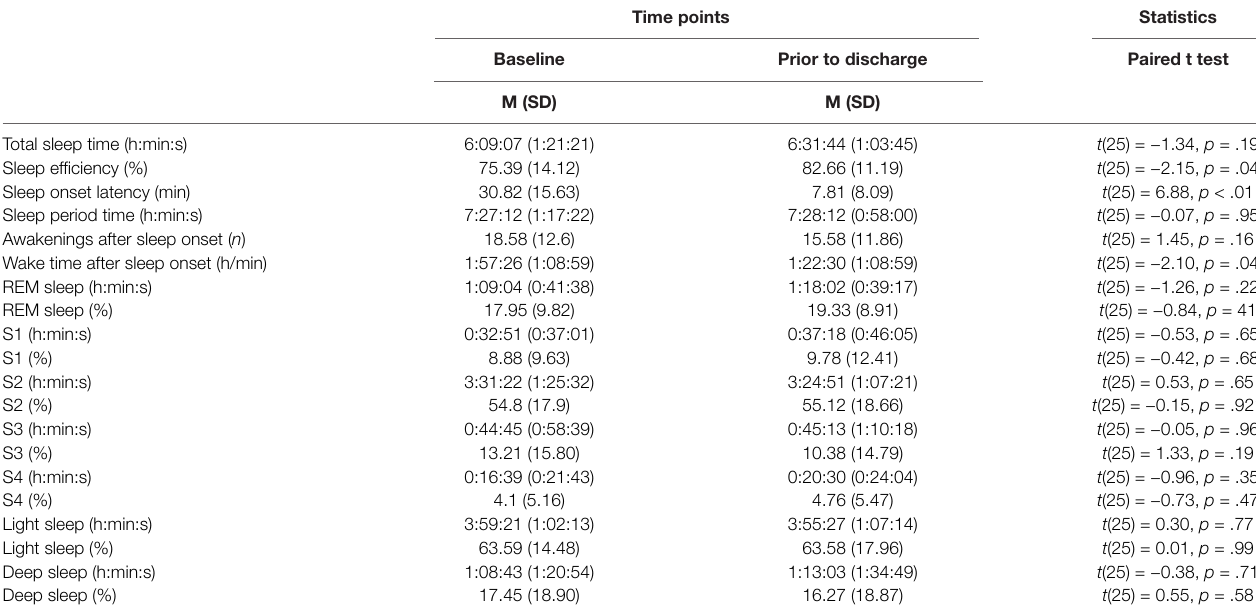
TABLE 1 | Objective sleep dimensions at baseline and at the study end.